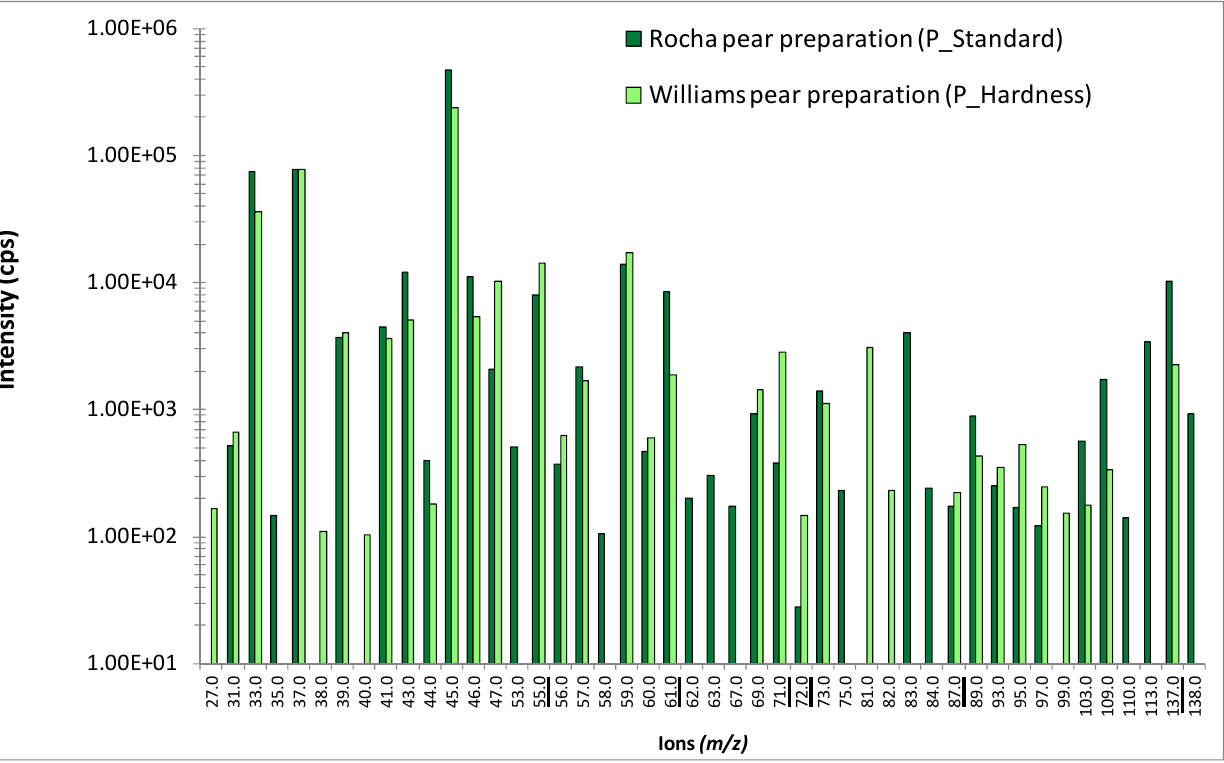
Figure 1. Comparison of PTR-MS spectra obtained from in vitro measurements performed in the headspace of the two pear preparations that varied in pear piece hardness (logarithmic scale). Peaks are labeled by their m/z ratios, and their intensity was determined by PTR-MS in scan mode. Underlined ions were selected for the in vivo study. The PTR-MS instrument drift tube was thermally controlled (60 °C) and operated